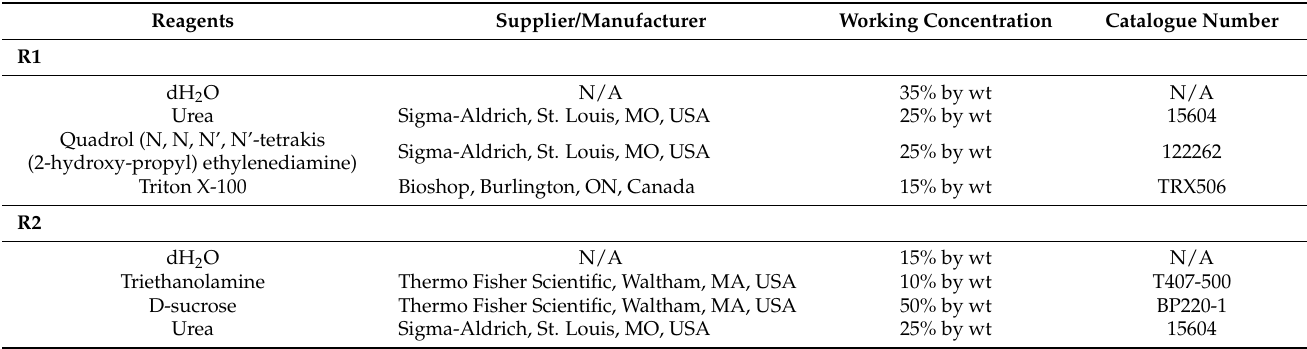
Table 6. CUBIC reagent 1 (R1) and CUBIC reagent 2 (R2) compositions .